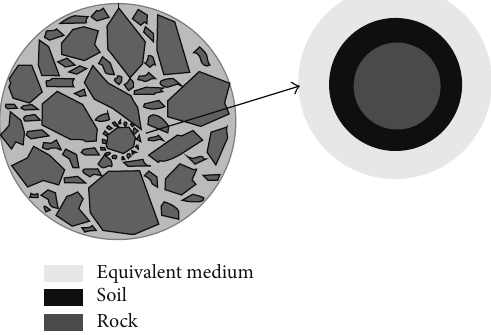
Figure 2: Two-layer embedded model and microstructure sectional drawing of soil-rock mixture.